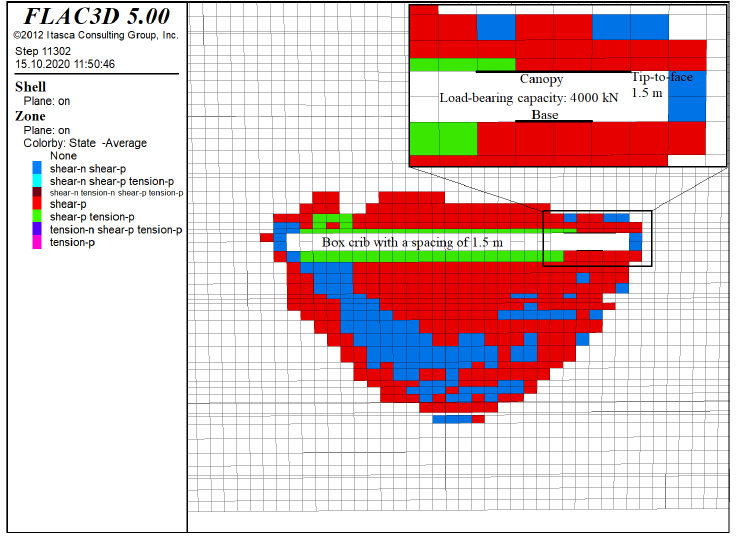
Figure 22: Plasticity around the longwall face with the selected influencing factors